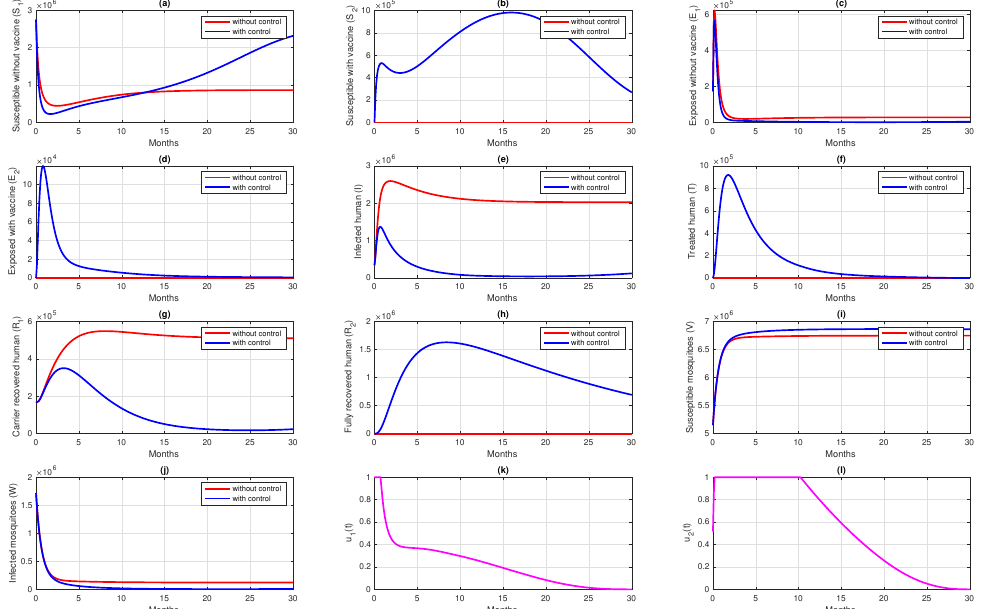
Figure 12. Dynamics of human ( a – h ), mosquitoes ( i , j ), and controls ( k , l ) under the scenario of both intervention applies, but with a higher number of infected individuals at time t = 0. Red and blue curve present a condition of without and with implementation of